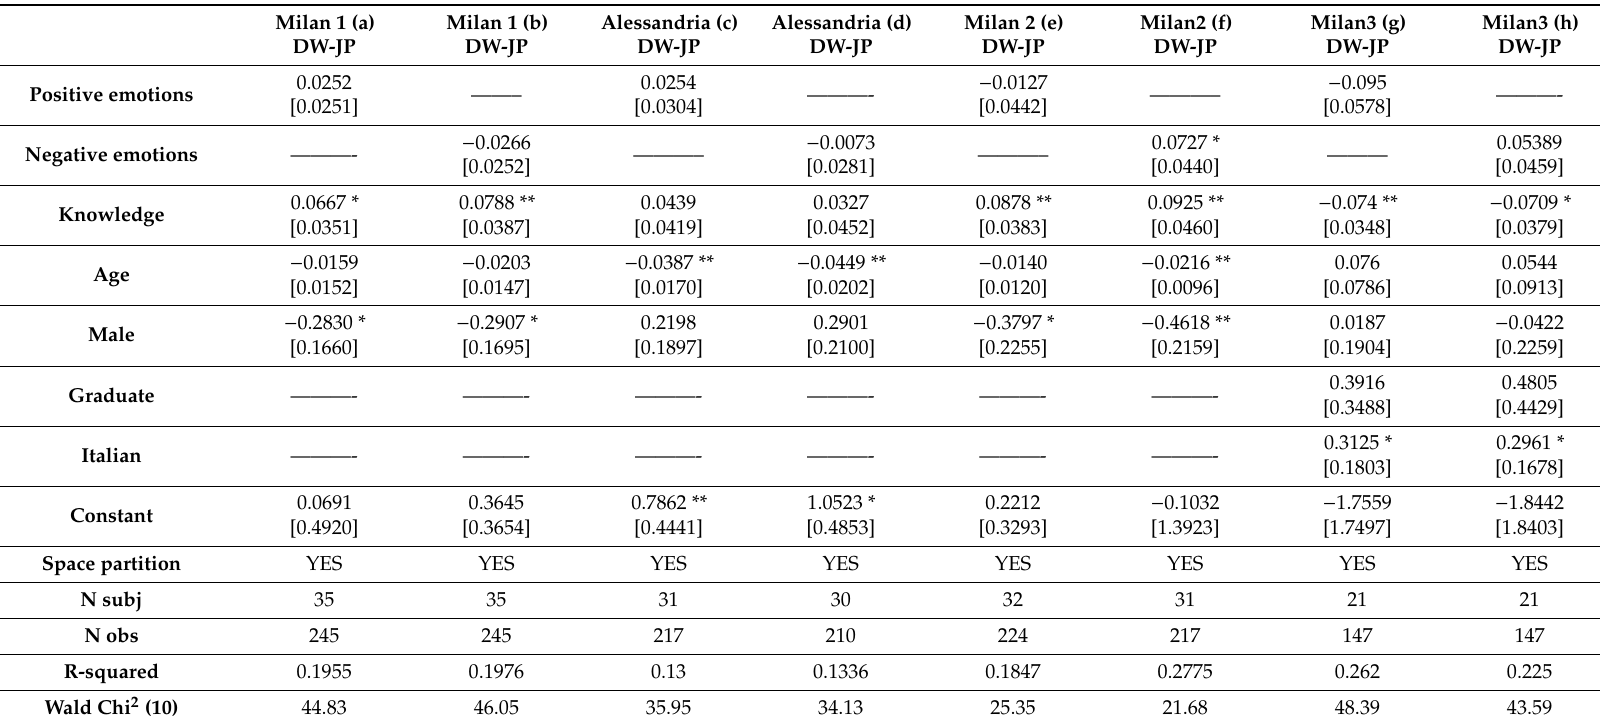
Table 4. Di ff erence between decision weights and judgemental